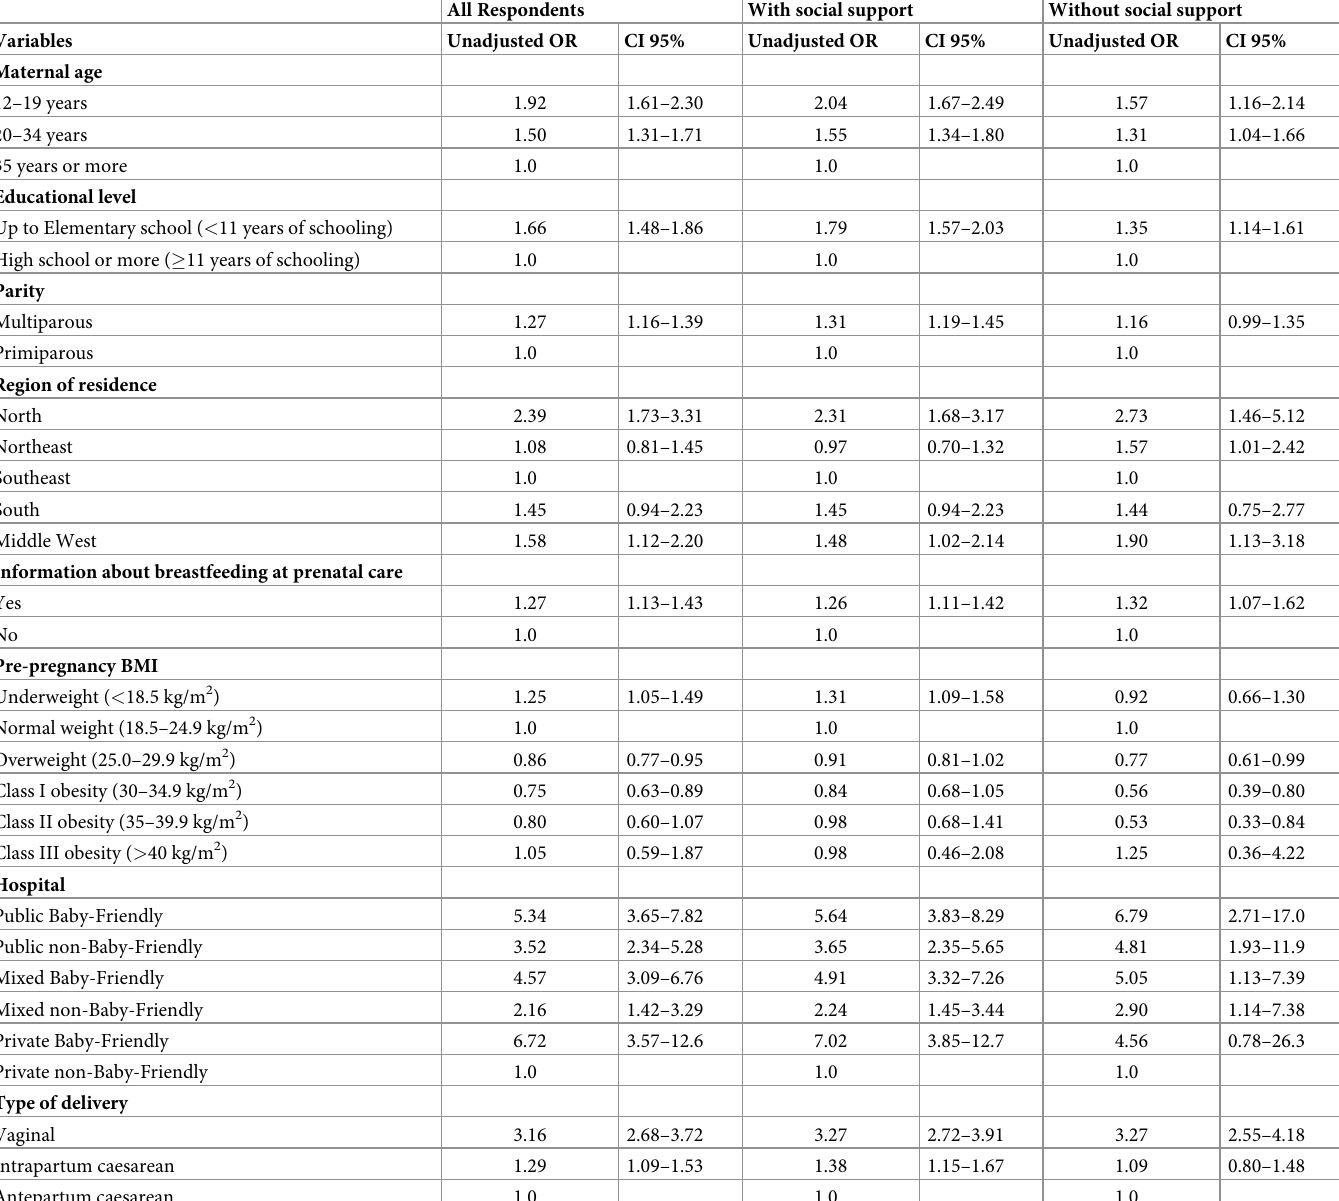
Table 2. Unadjusted factors associated with breastfeeding in the first hour after birth, according to mother, newborn and hospital characteristics by social support status, Brazil,